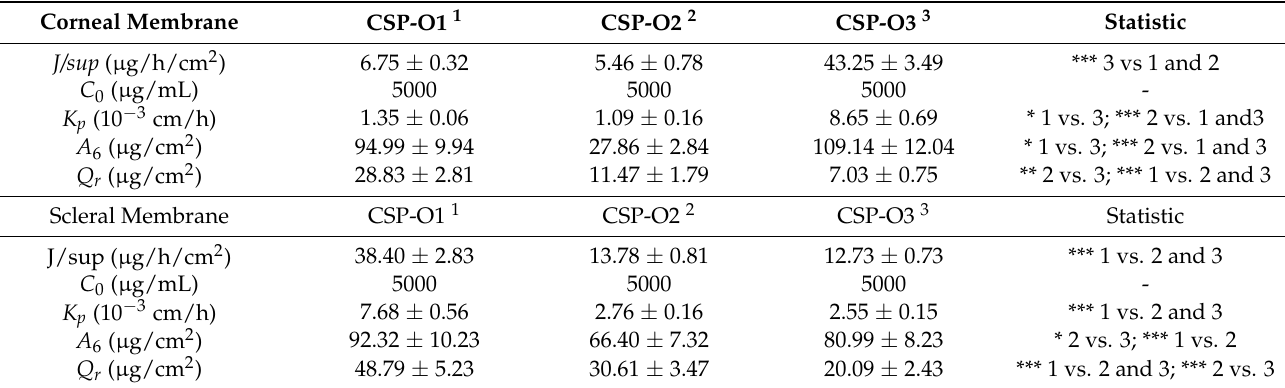
Table 4. Estimated permeation and retention parameters of CSP formulations on corneal and scle- ral membranes in the section where the curves are linear (first hour). Values are reported as the mean ± SD ( n = 6). J/sup : flux normalized by surface; C 0 : initial concentration in the donor compart- ment; K p : permeability constant; A 6 : cumulatively permeated amount of CSP at 6 h; Q r : amount of CSP retained in the